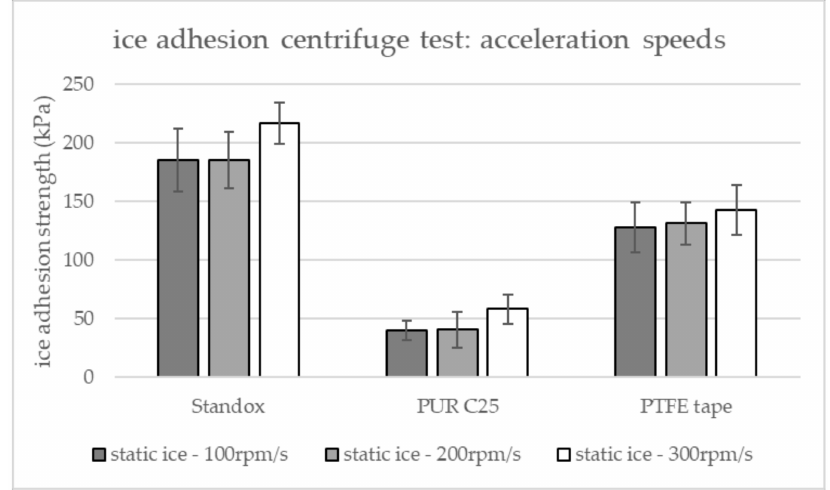
Figure 7. Comparison of the ice adhesion test results at different centrifuge acceleration speeds.